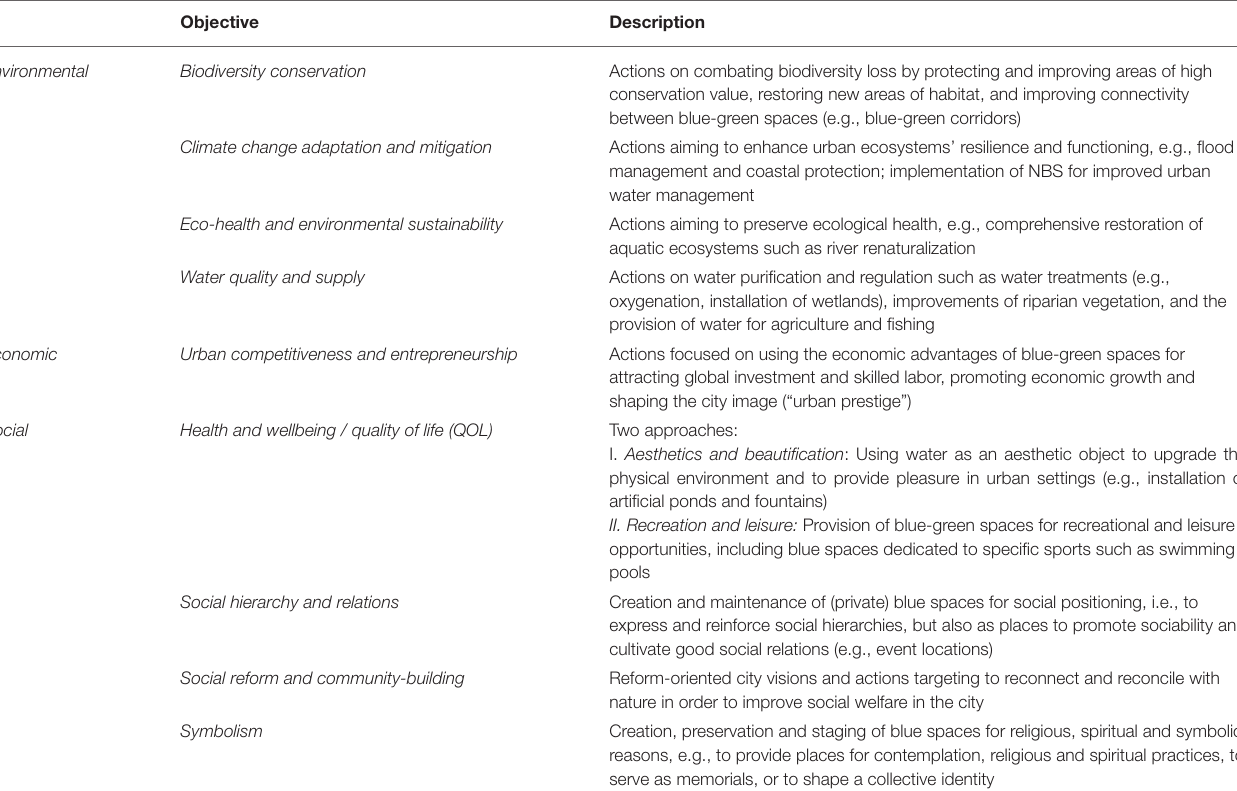
TABLE 4 | Objectives for urban blue regeneration [modified from (13,